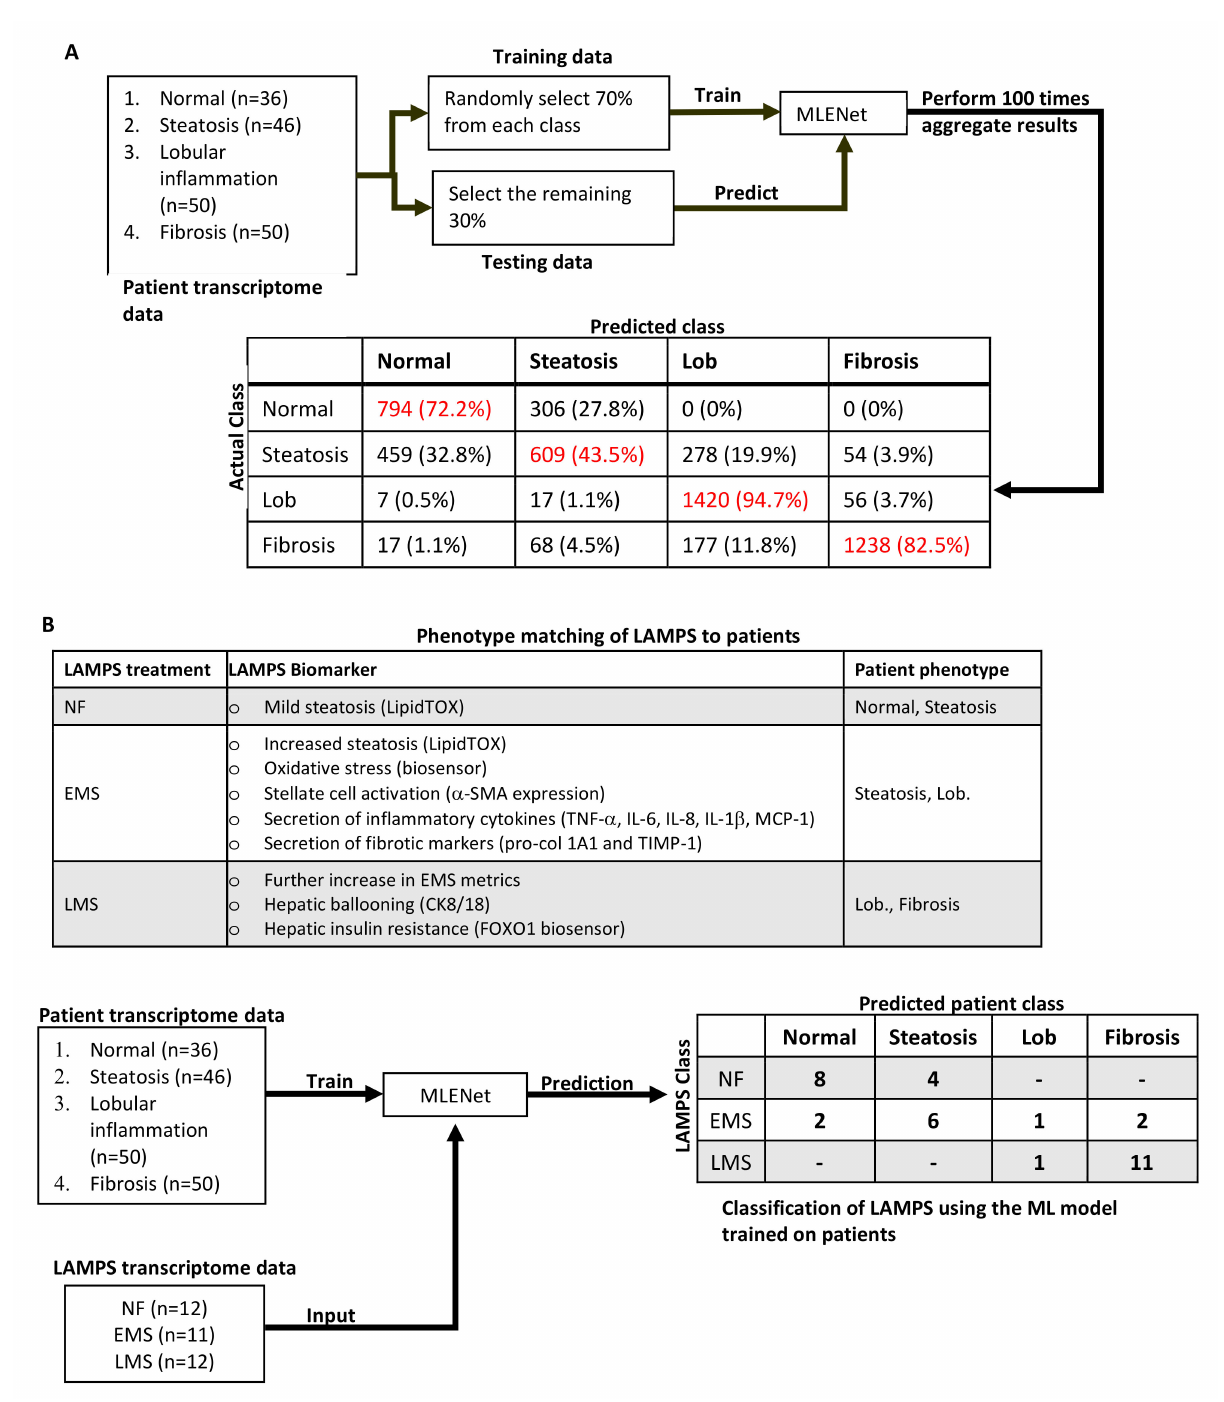
Figure 4. Unbiased machine learning model of patient transcriptomic data identifies and predicts congruent clinical phenotypes within LAMPS. ( A ) The bootstrapping procedure used to develop and validate the transcriptome-based machine learning model (MLENet) capable of differentiating and predicting 4 NAFLD patient classifications (see Methods) (red indicates the clinically defined true positives). The average sensitivity across the bootstrapping instances (numbers in parenthesis are standard deviations) are: 0.66 (0.11), 0.64 (0.12), 0.77 (0.08), 0.93 (0.07); average specificity 0.93 (0.03), 0.83 (0.03), 0.98 (0.02), 0.95 (0.03) for normal, steatosis, Lob, and fibrosis, respectively. ( B ) The workflow and table of outcomes from implementing MLENet to identify and predict congruent NAFLD patient phenotypes from LAMPS transcriptomic analytes generated under normal fasting (NF); early metabolic syndrome (EMS); or late metabolic syndrome (LMS) conditions (see